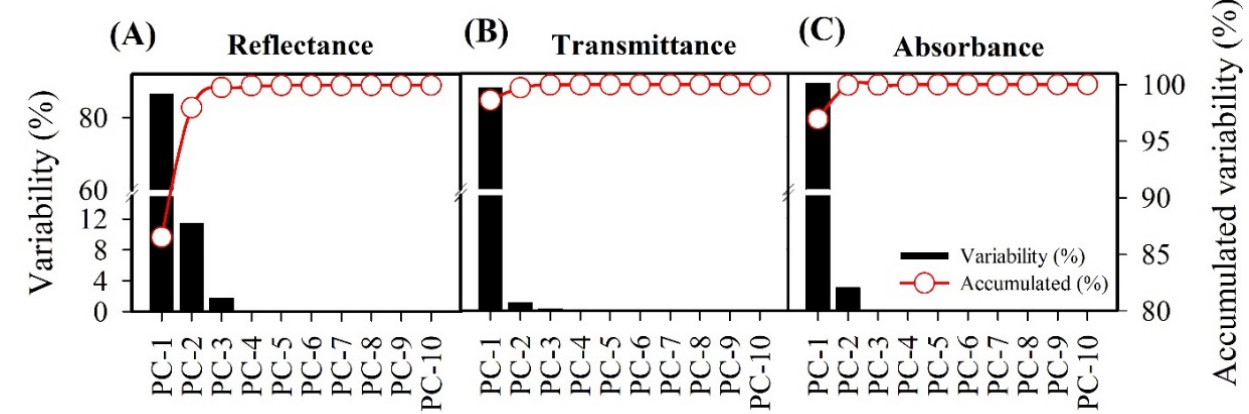
Figure 5. Principal component analysis (PCA) and PC scores obtained from hyperspectral analysis of lettuce plants: ( A ) reflectance, ( B ) transmittance, ( C ) absorbance. Black bars indicate variability of PC, red circles indicate accumulated variability.